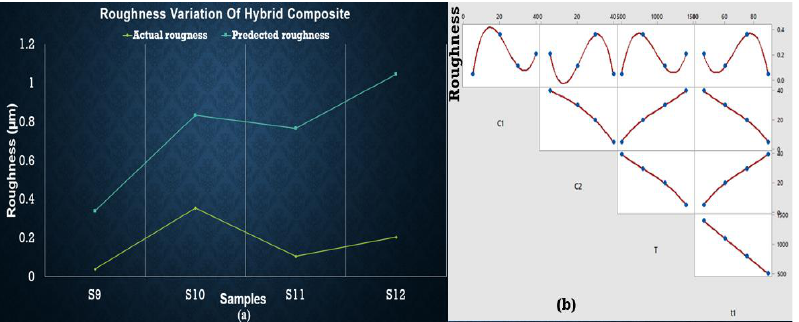
Figure 10. ( a ) Regression plot for Al-SiC-ZrSiO 4 showing overlapping of actual and predicted rough- ness values points (yellow line presents actual value of hardness and blue line shows predicted values). ( b ) Matrix plot showing the individual relationship between roughness and input variables for Al-SiC-ZrSiO 4 .